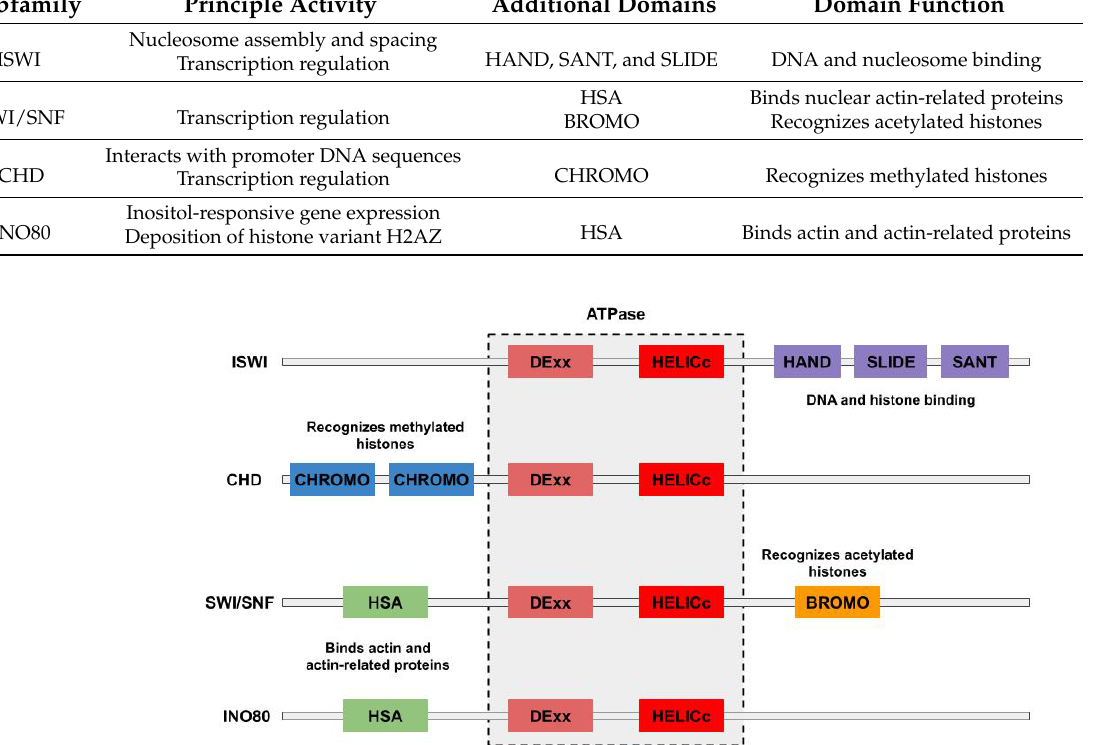
Figure 2. Pictorial representation of the domains conserved within each subfamily of chromatin remodelers. The DExx and HELICc domains are common to all chromatin remodelers and are found within the catalytic ATPase subunit. The HSA domain, responsible for binding actin and actin- related proteins, is common to both SWI/SNF and INO80 chromatin remodelers, but only SWI/SNF chromatin remodelers possess a BROMO domain, which is involved in recognizing acetylated histone proteins. The HAND, SLIDE, and SANT domains are unique to ISWI chromatin remodelers and play roles in DNA and histone binding. Only CHD remodelers possess CHROMO domains that are involved in recognizing methylated